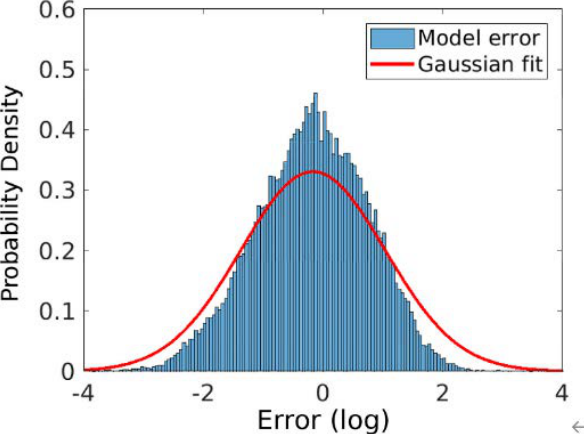
Fig. 5 The distribution of the calculated value of the deterministic model in the confidence interval of the probability model